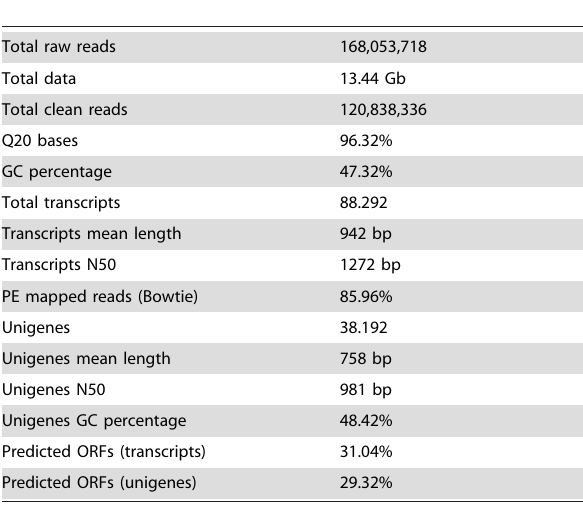
Table 1. Summary of assembled transcripts and unigenes of P. maximum